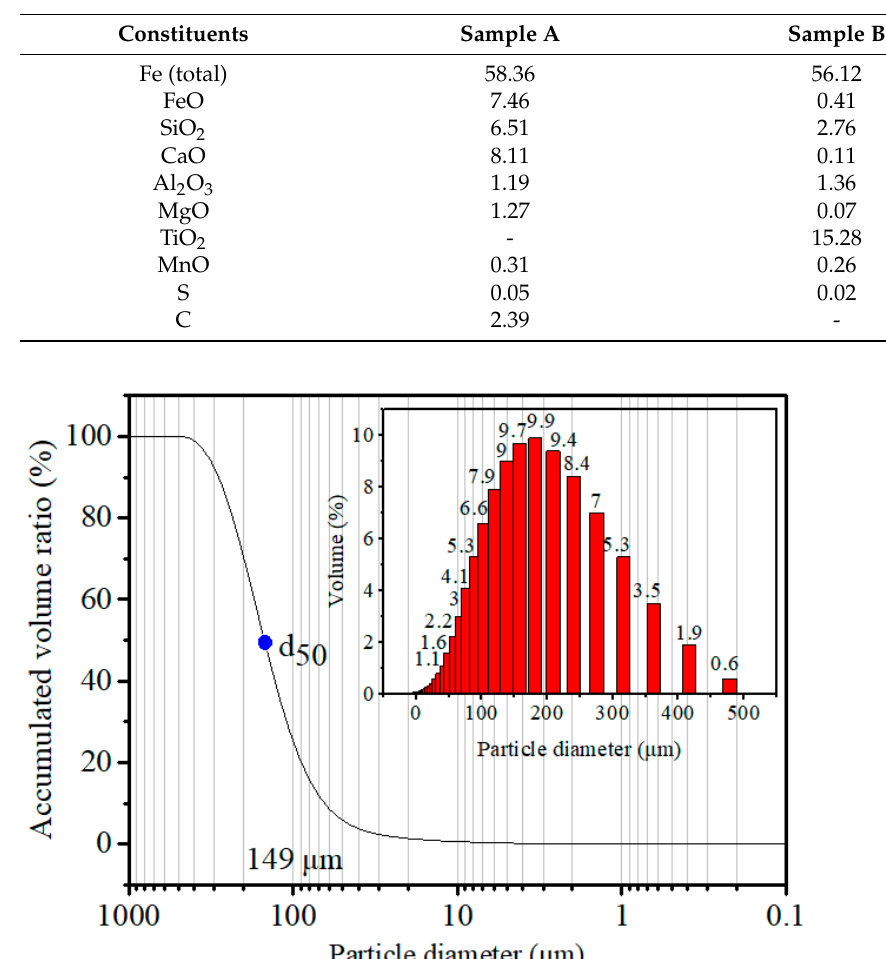
Figure 2. Size distribution of the